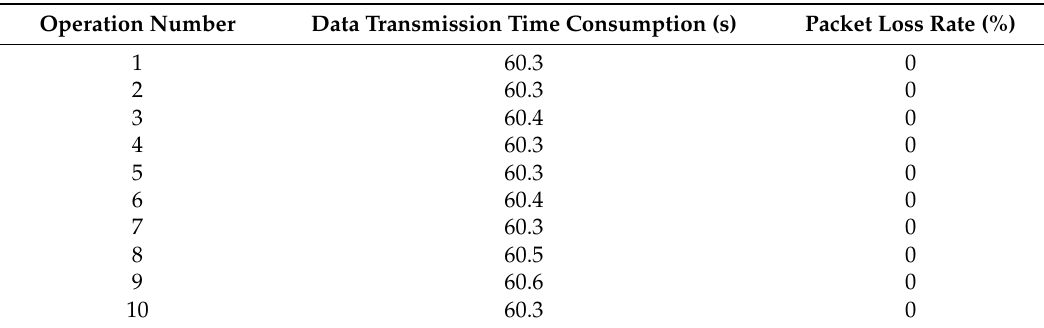
Table 3. Records of 10 test